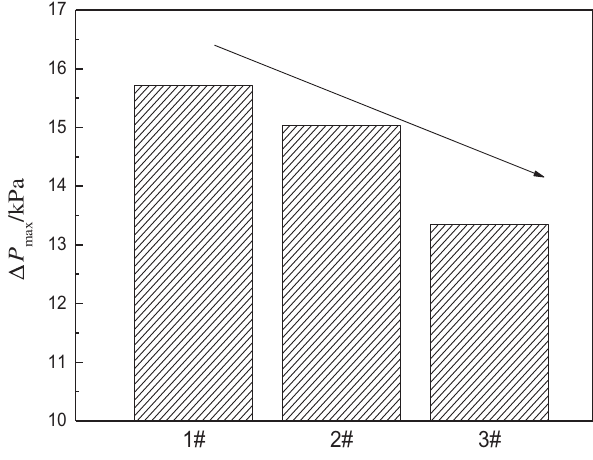
Figure 4: Δ P max with different w (Cl - ).